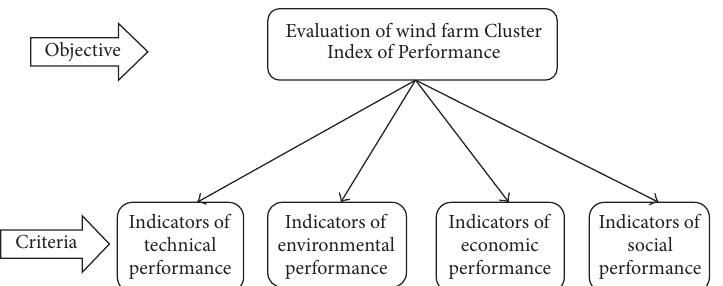
Figure 3: AHP framework for fixing weights of the